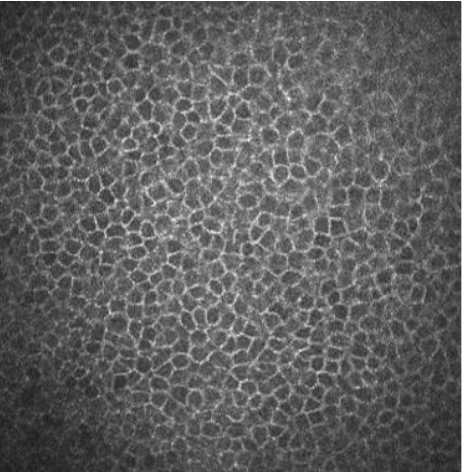
Figure 1. Basal epithelial cells of a human cornea observed with the corneal confocal microscopy HRT II.